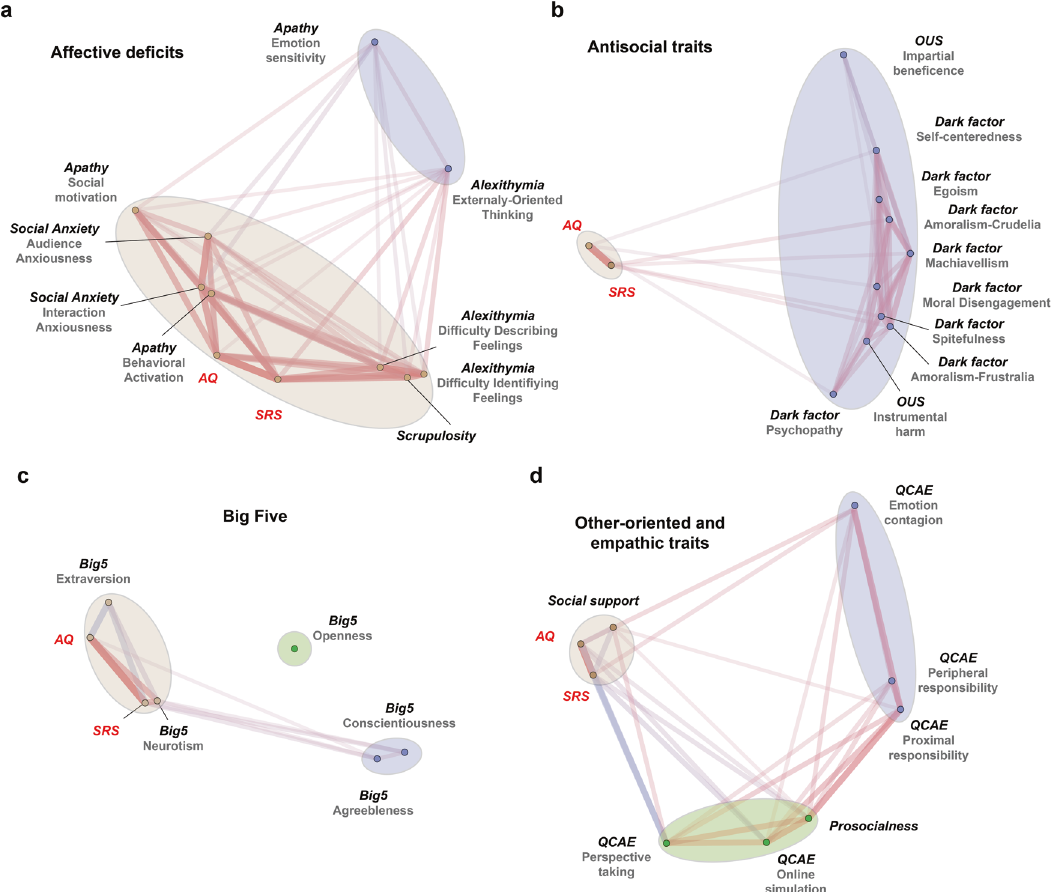
Fig. 1 Visualization of personality trait networks. We categorized the personality measures (other than the autistic trait measures) into four groups. We then illustrated the networks consisting of autistic traits (highlighted in red) on the one hand, and each of these groups of personality measures on the other hand: a Affective de fi cits (including Social Anxiety, Apathy, Alexithymia, and Moral Scrupulosity), b Antisocial traits (including the Dark Factors, and utilitarianism), c the Big Five, and d Other-oriented and empathic traits (including QCAE, Perceived Social Support, and Prosocialness). Each dot in the fi gure indicates a personality subscale. Length of edges connecting the dots indicates the statistical distance (i.e., absolute correlation coef fi cient) between the subscales. Color of the edges indicates the sign of the relationship (i.e., warm color = positive association, cool color = negative association). Ellipses were drawn to re fl ect potential clusters in each network, which were formally examined in the factor analysis